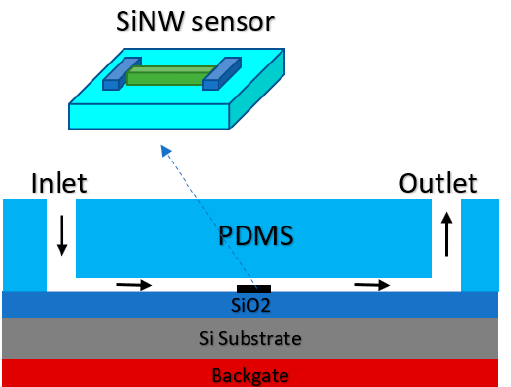
Figure 16. The schematic of silicon nanowire (SiNW) integrated with PDMS microfluidic channel which was designed to direct the flow of sample of interest toward the solution. An Ag/AgCl electrode is integrated by placing its tip in the inlet of the microfluidic channel.